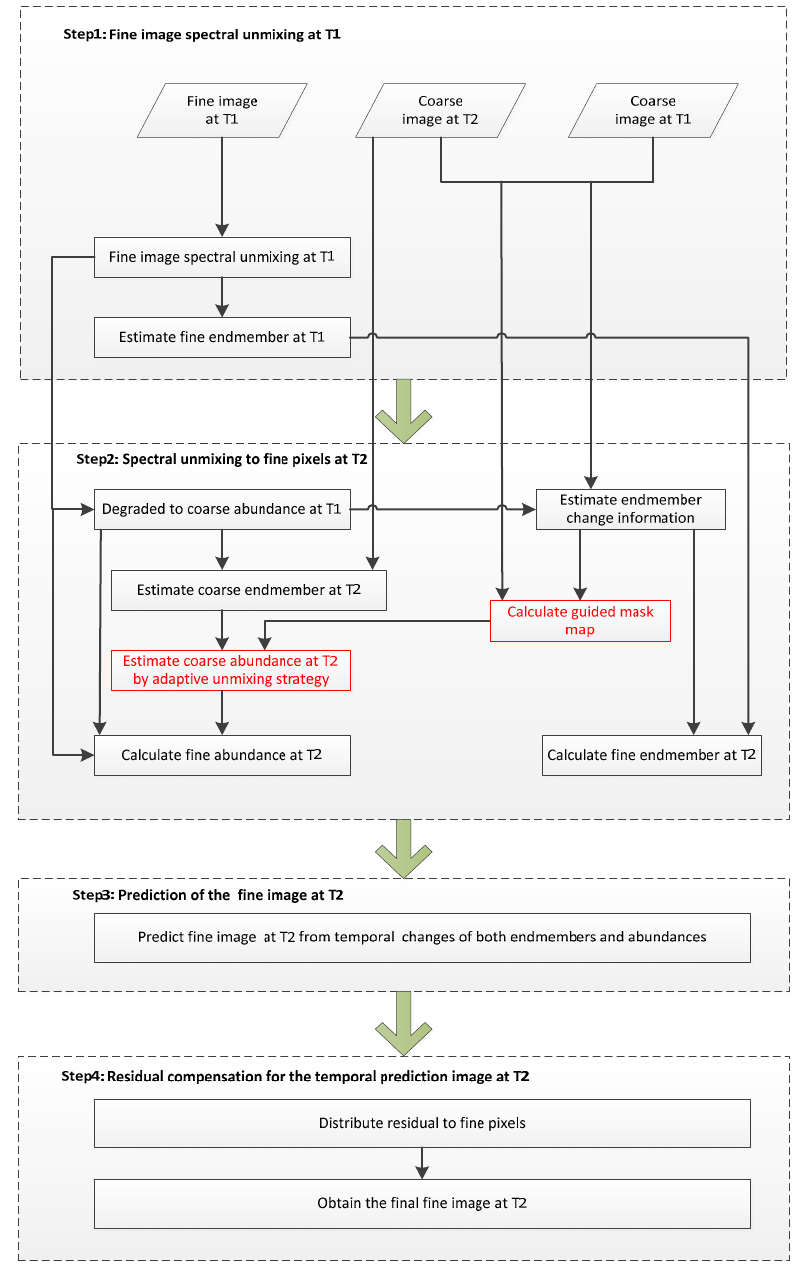
Figure 1. Flowchart of the proposed adaptive- sub-pixel class fraction change information incorporated in Flexible Spatiotemporal DAta Fusion (SFSDAF).